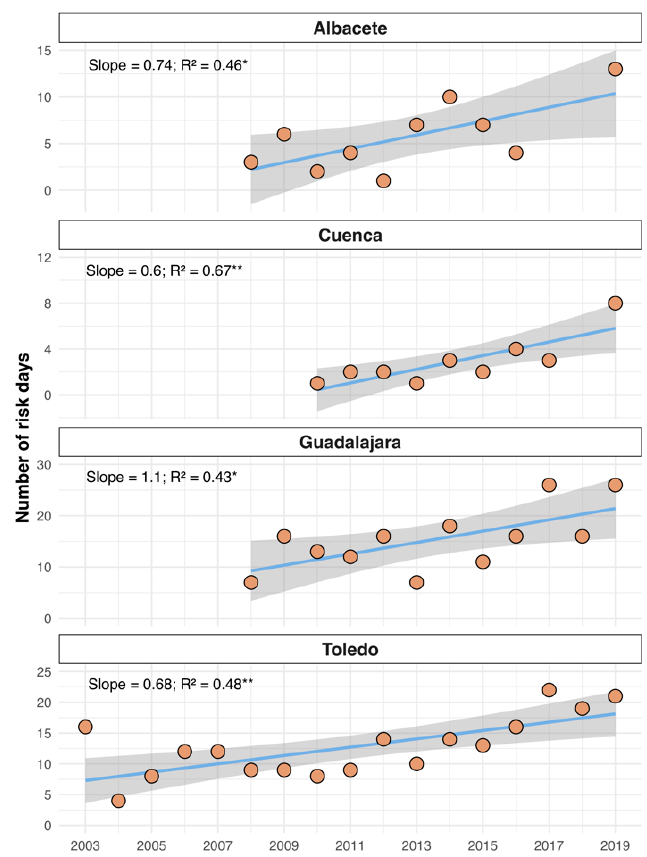
Figure 2. Trends of the annual pollen integral of Platanus pollen. Levels of significance: * p < 0.05, ** p < 0.01. Blue line represents the regression line and grey zone corresponds to 95% confidence interval.